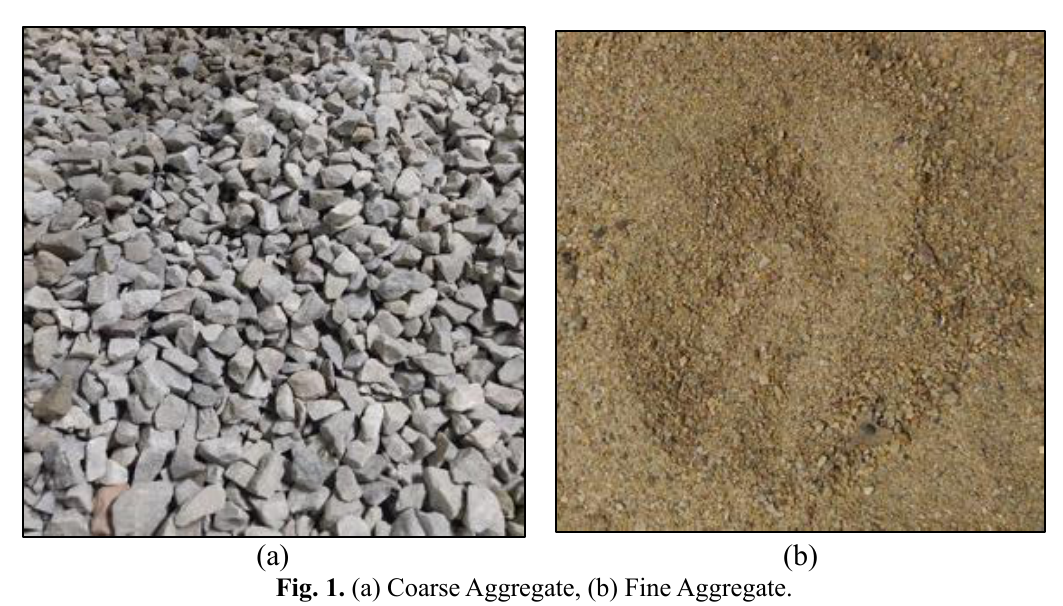
Aggregate physical properties. Physical Property FA (Sand) CA (Stone Chips) Bulk Specific Gravity (OD